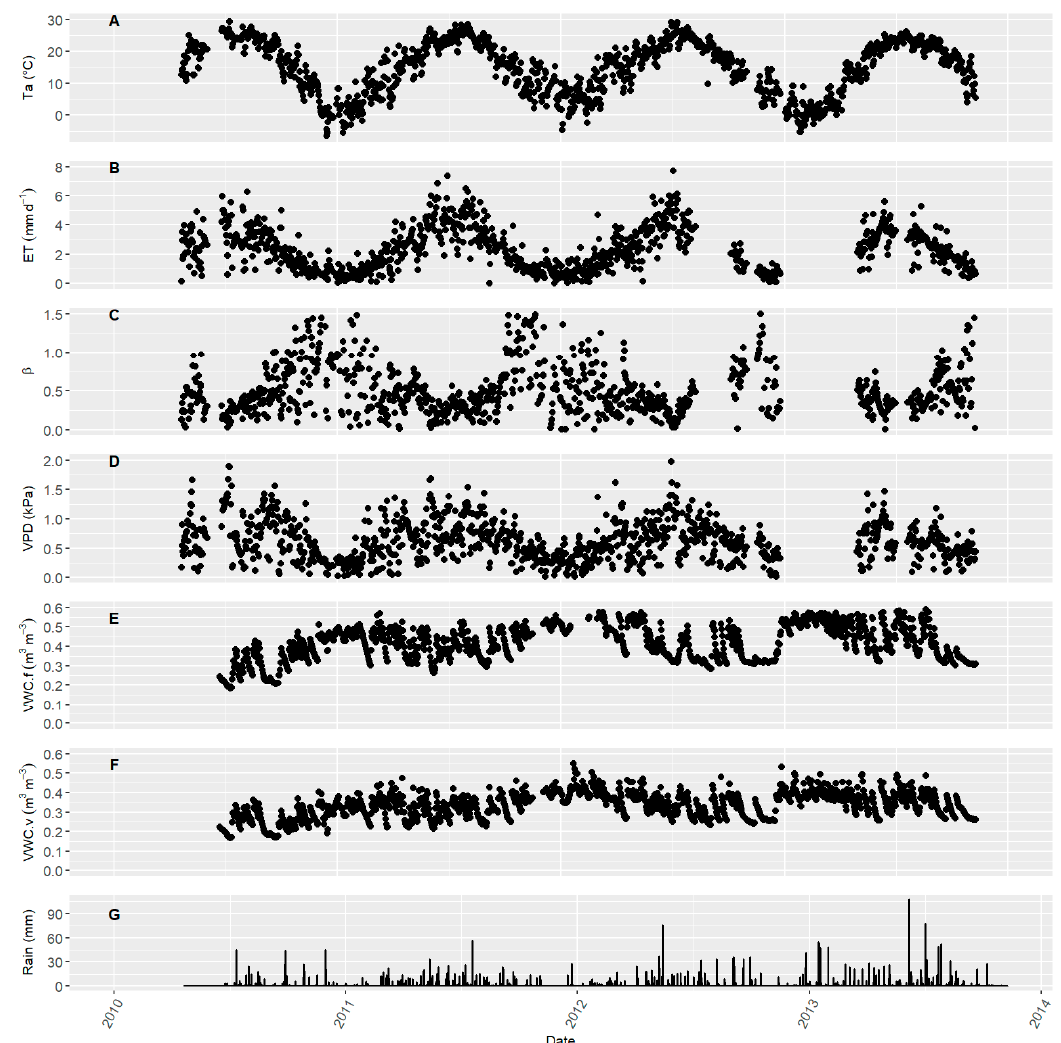
Figure 1. Daily air temperature (Ta) ( A ), evapotranspiration (ET) ( B ), and Bowen Ratio ( β ) ( C ), vapor pressure deficit (VPD) ( D ), volumetric soil water content in 6 cm soil depth under tall fescue (VWC.f) ( E ), and grapevines (VWC.v) ( F ), and daily precipitation ( G ) from 2010 to 2013 in a NC vineyard.